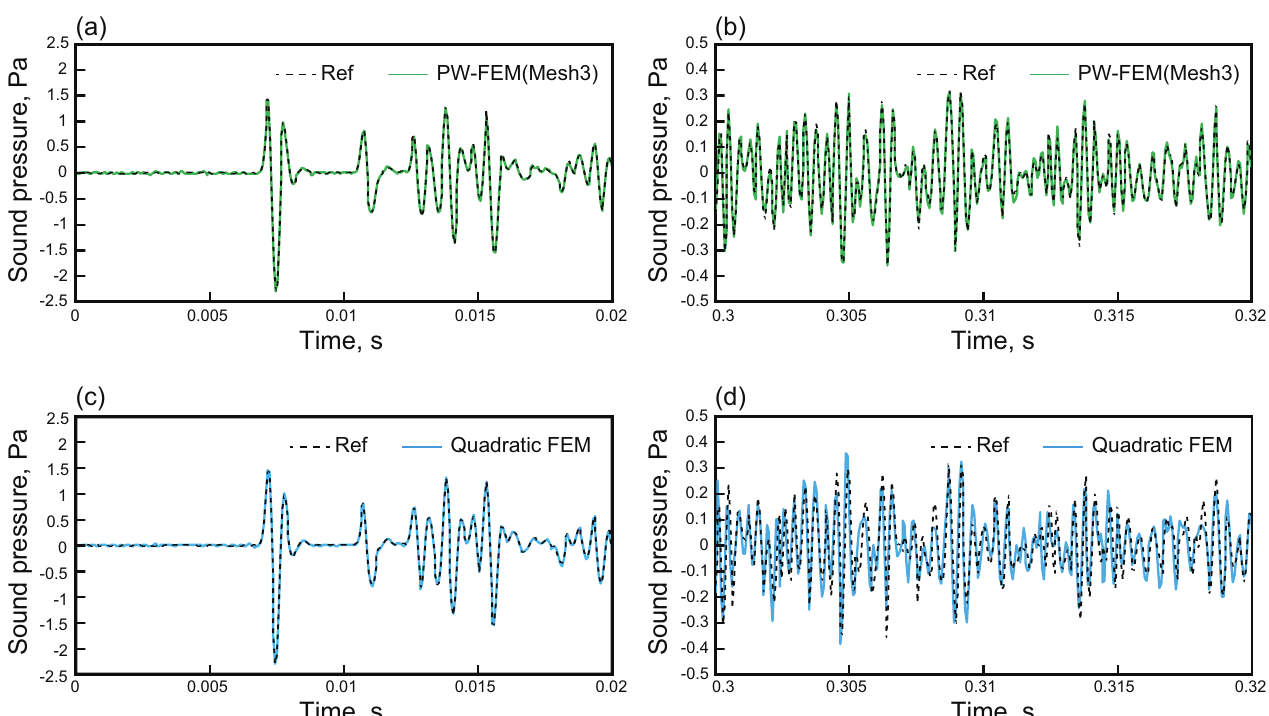
Figure 10. Comparisons of the waveforms at R1 between ( a ) the reference solution (Ref) and the PW-FEM (Mesh 3) at time t = 0–0.02 s, ( b ) the Ref and the PW-FEM (Mesh 3) at time t = 0.3–0.32 s, ( c ) the Ref and the quadratic FEM at time t = 0–0.02 s, and ( d ) the Ref and the quadratic FEM at time t = 0.3–0.32 s.